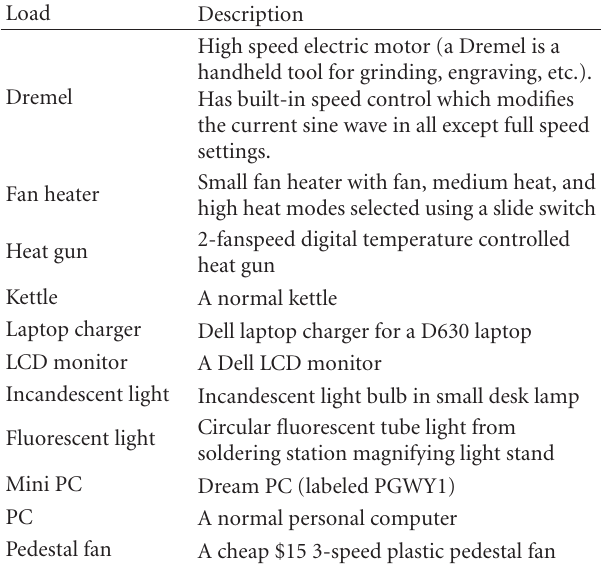
Table 1: Data collecting